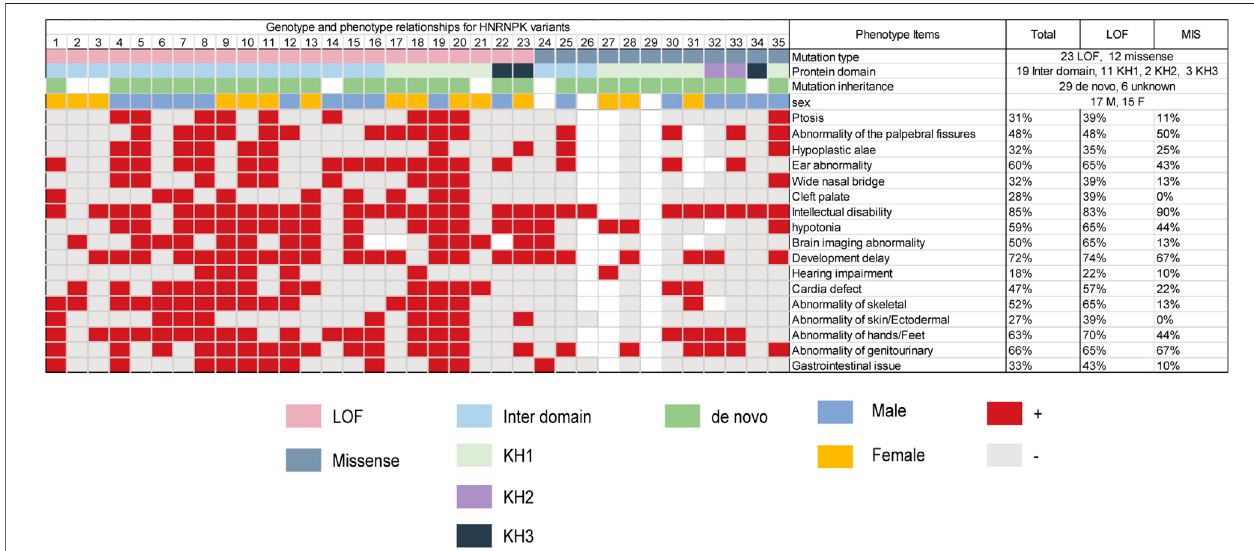
FIGURE 3 | Genotype and phenotype relationships for HNRNPK variants. Pink boxes represent loss-of-function variants; Navy blue boxes represent missense variants; Green boxes represent de novo ; blue boxes represent male; yellow boxes represent female; red boxes represent present. Light gray boxes represent absent; white boxes represent unreported. Total (%) represents the number of patients who were reported to have the speci fi c phenotype (numerator) divided by the number of patients. LOF (%) represents the number of patients with LOF variants who were reported to have the speci fi c phenotype (numerator) divided by the number of patients with LOF variants. MIS (%) represents the number of patients with missense variants who were reported to have the speci fi c phenotype (numerator) divided by the number of patients with missense